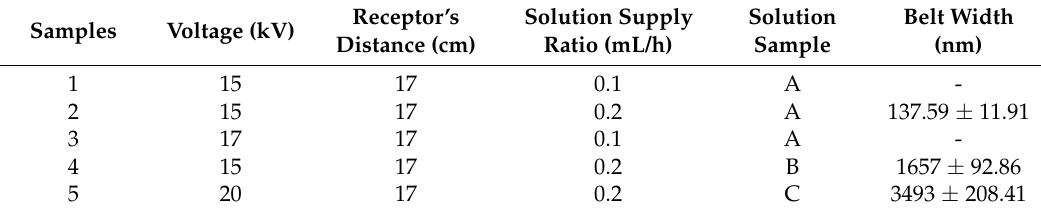
Table 2. Spinning